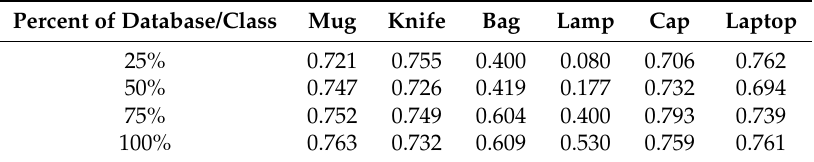
Figure 7. An example of the dense database with similar consecutive objects. Table 5. Accuracy of the component annotation by MST with different numbers of objects in the